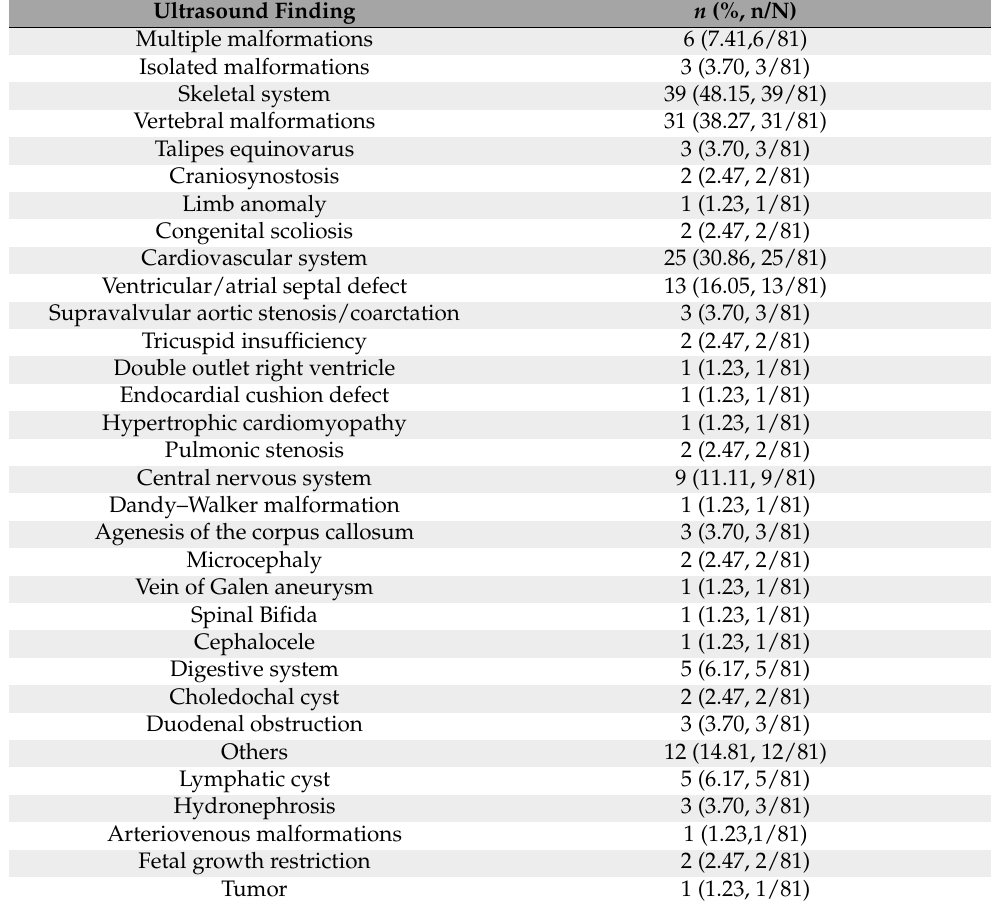
Table 2. Classification of abnormal ultrasound findings in 81 fetuses with 16p11.2